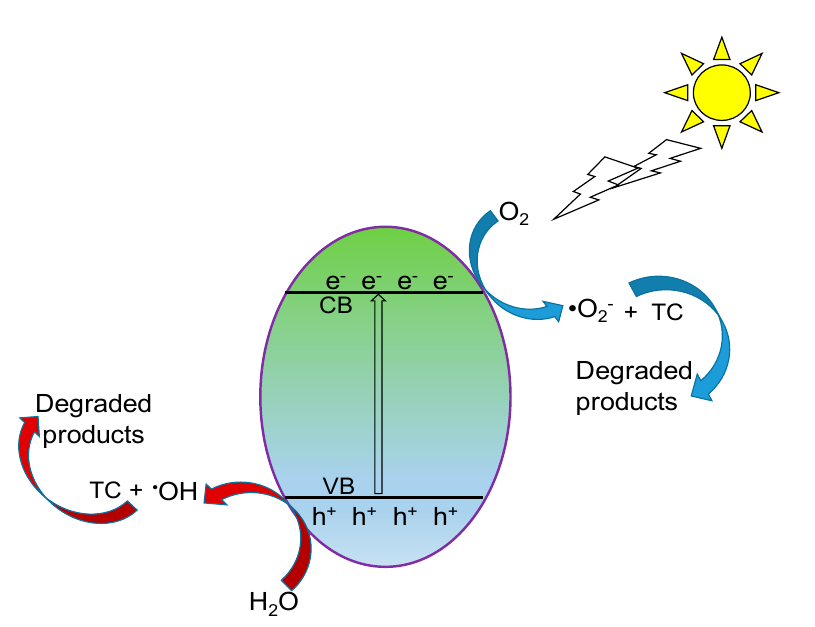
Figure 10. The schematic representation of the possible photocatalytic mechanism involved in the degradation of TC under visible light irradiation.